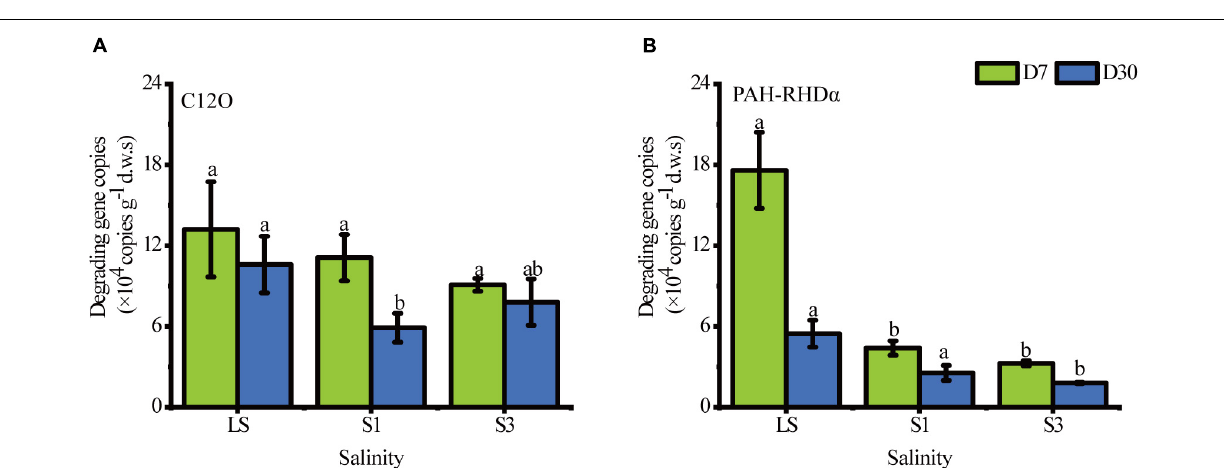
FIGURE 2 | Soil enzyme activities in the LS, S1 and S3 treatments. (A) the 7 th day, (B) the 30 th day. Different letters over columns represent significant differences among treatments at the p < 0.05 level of LSD post hoc comparison tests.